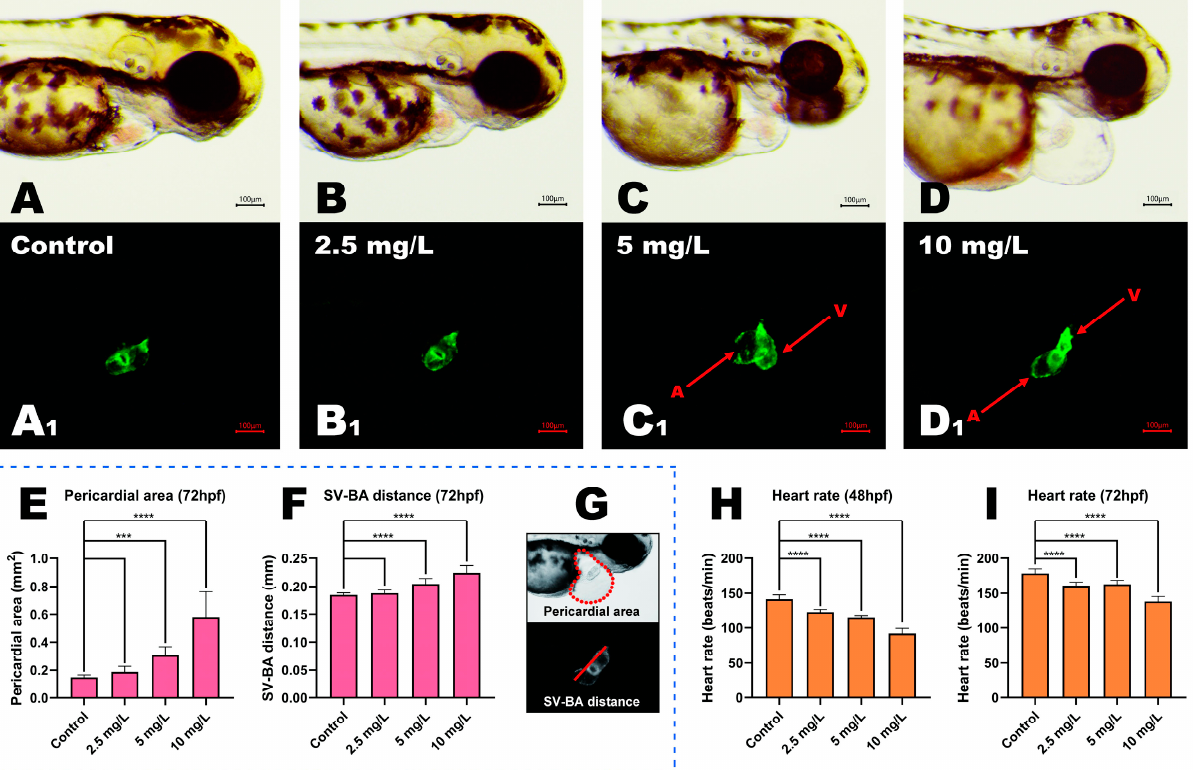
Figure 2. Cardiac morphological changes and functional impairment in zebrafish exposed to MP. ( A – D ) Brightfield microscopy of embryos at 72 hpf. ( A1 – D1 ) Fluorescent microscopy at 72 hpf; the A in the figure represents atria while V represents ventricles. ( E ) Pericardial area and ( F ) SV-BA distance at 72 hpf; SV-BA is the distance between the embryonic cardiac venous sinus and bulbous artery bulb. ( G ) Diagram showing the pericardial area and the SV-BA distance. ( H , I ) Heart rate at 48 and 72 hpf. (mean ± SD, n = 3, ANOVA, post hoc Dunnett’s multiple comparison test, *** p < 0.001, **** p < 0.0001).